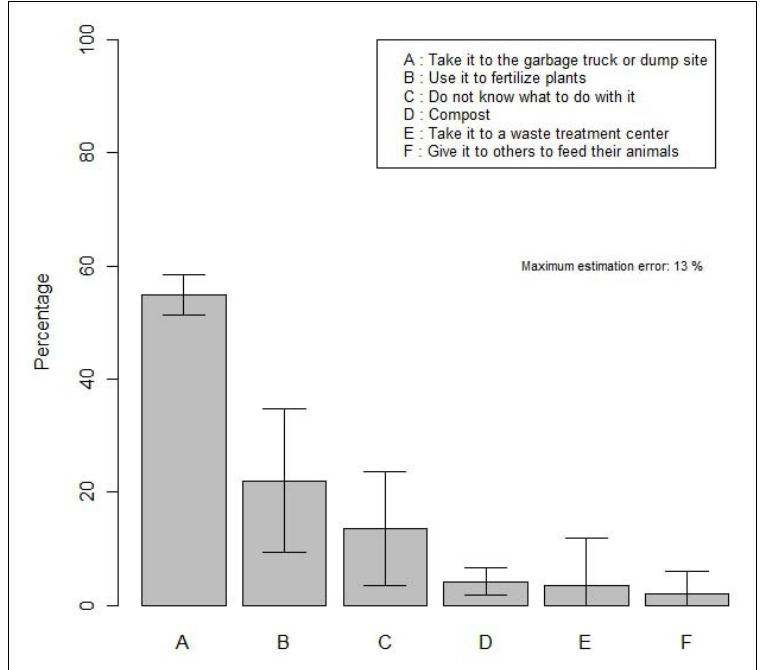
Figure 5. Actions To Be Taken with Separated Organic Waste Among Respondents Willing To Separate